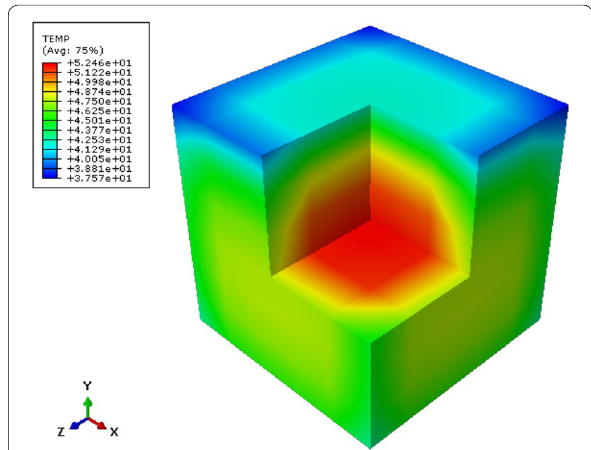
Fig. 11 Temperature distribution (in °C) within the concrete cube 12 h after casting.